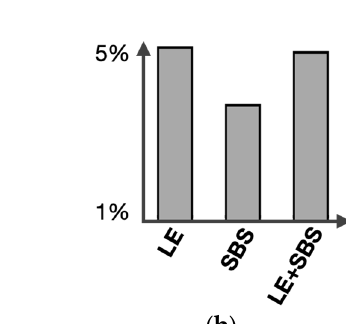
Figure 3. Example of experiment-model best-matching 3D structures, along with their corresponding single-molecule distance maps, as identified by the RMSD method. Adapted from [28].